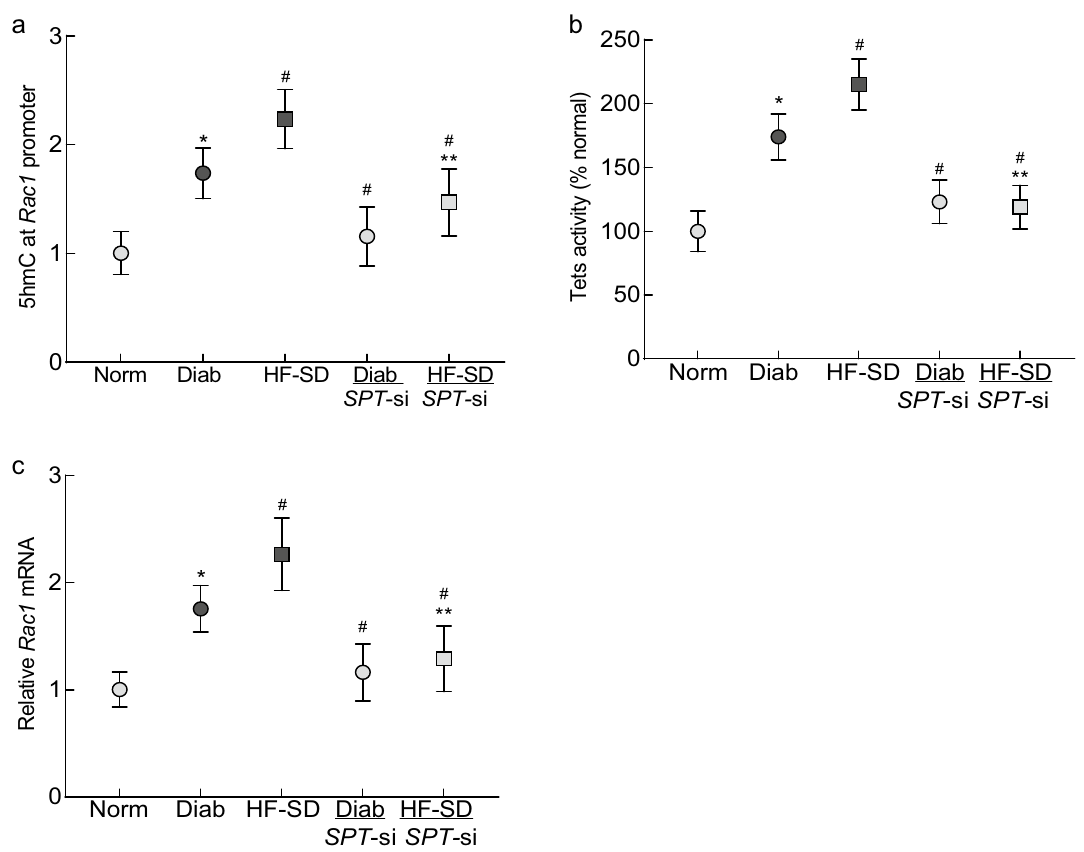
Figure 7. Regulation of SPT and Rac1 transcriptional activation in diabetic mice. ( a ) 5hmC levels at Rac1 promoter, ( b ) activity of Tets and ( c ) relative Rac1 mRNA were measured in retinal microvessels from 5–6 mice/ group, and the values are represented as means ± SD. Norm and Diab = normal or diabetic mice on regular chow; HF-SD = diabetic mice on high fat chow; Diab/ SPT -si or HF-SD/ SPT -si = diabetic mice on regular chow or high fat chow, respectively, receiving SPT -siRNA intravitreally. *p < 0.05 vs Norm, # p < 0.05 vs Diab and # **p < 0.05 vs